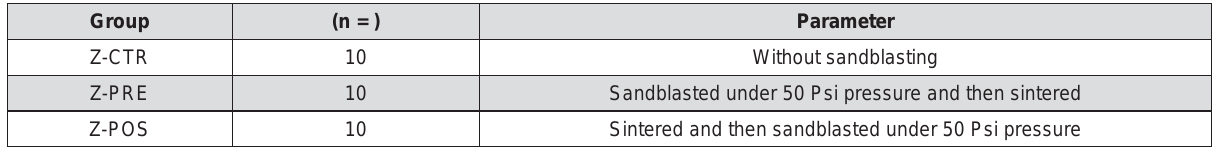
Figure 1- Surface treatments for